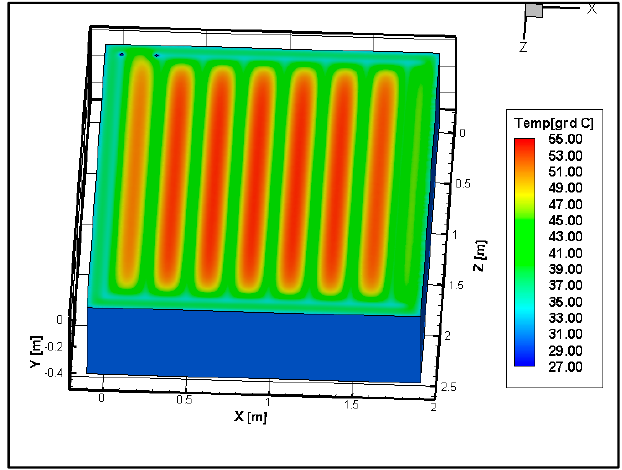
Figure 7. Temperature fields at the external surface and in longitudinal cross-section.